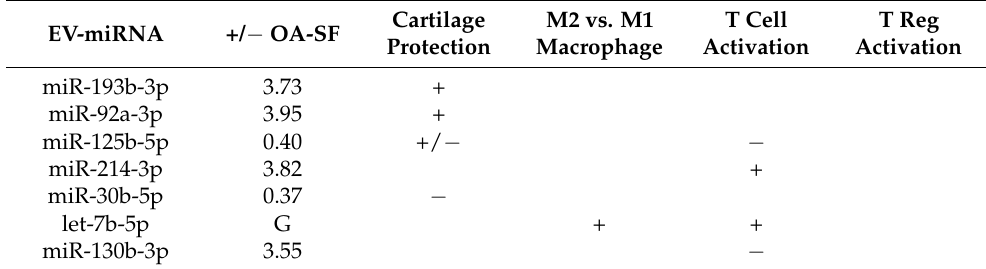
Cartilage M2 vs. M1 T Cell T Reg Protection Macrophage Activation Activation